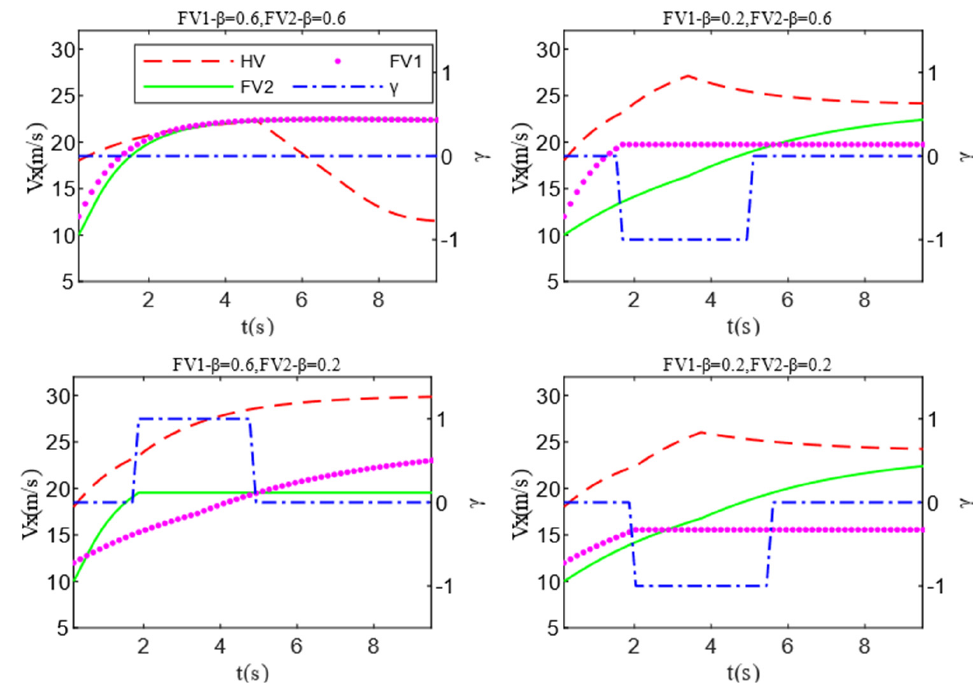
Figure 14. Velocity test results of Scenario B.